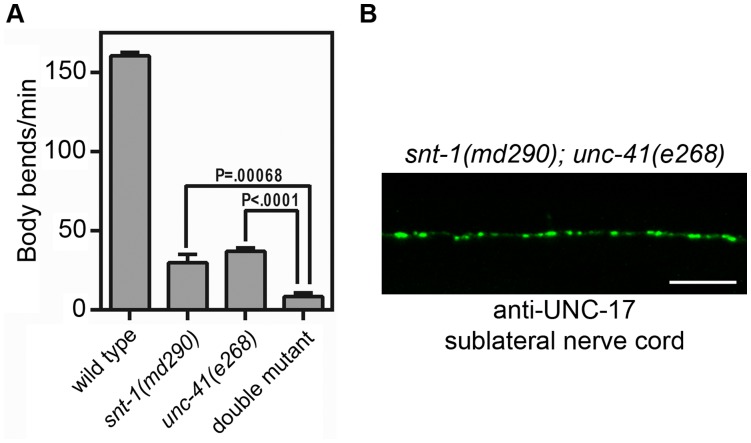
Analysis of snt-1 unc-41 double mutants.(A) Swimming assays of wild type, snt-1(md290), and unc-41(e268) single mutants, and snt-1(md290); unc-41(e268) double mutants (details in Materials and Methods). Each bar represents the mean number of body bends/min for 20 individuals of each strain; error bars indicate SEM. Comparable results were observed with snt-1(md184); unc-41(e268) and snt-1(md290); unc-41(md152) double mutants (data not shown). (B) Immunohistochemical staining for the synaptic vesicle protein UNC-17/VAChT in snt-1(md290); unc-41(e268) double mutants, demonstrating proper subcellular localization of this protein. Shown is a confocal image of cholinergic synapses in a body-sublateral nerve cord of a young adult hermaphrodite; anterior is to the left, and the scale bar is 10 µm.